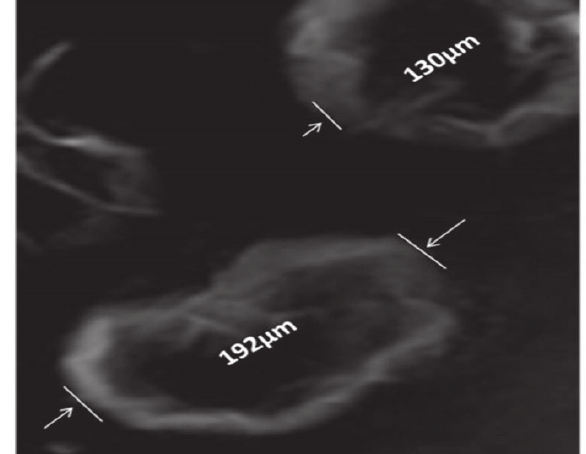
FIGURE 4 -: SEM image of F3 ethosomes.